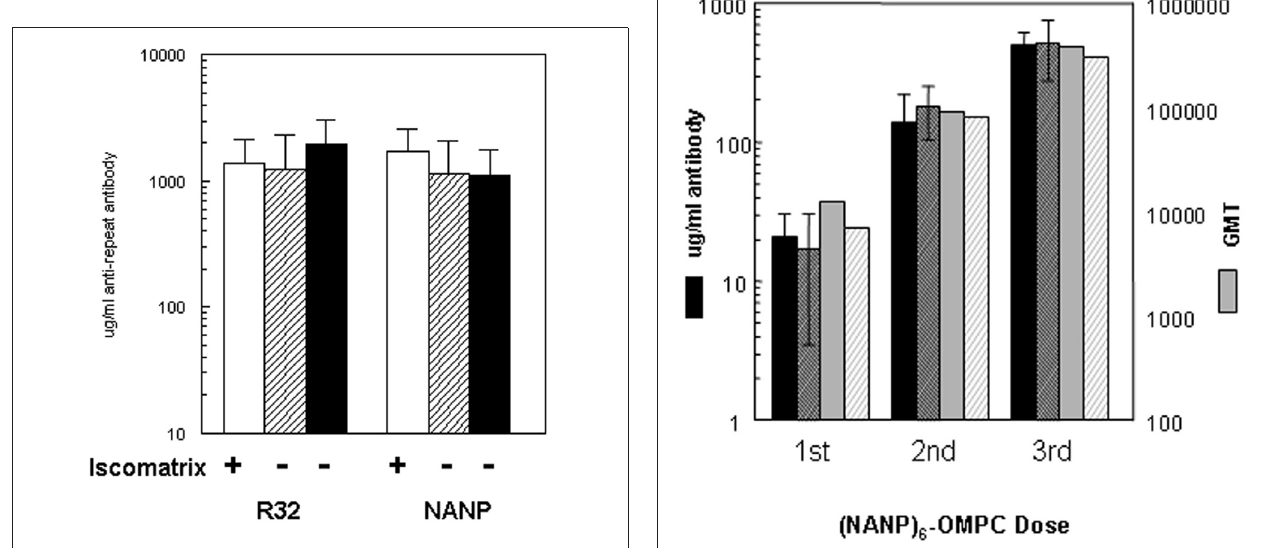
FIGURE 2 | Immunogenicity of (NANP) 6 -OMPC/MAA in C57Bl/6 mice. Kinetics of anti-repeat antibody response shown for two experiments (solid bars Experiment I, hatched bars Experiment II). Antibody concentration is shown as µ g/ml (left axis) or geometric mean titers (GMT) (right axis), as measured in ELISA using either R32 (black bars) or (NANP) 3 peptide (gray bars) as coating